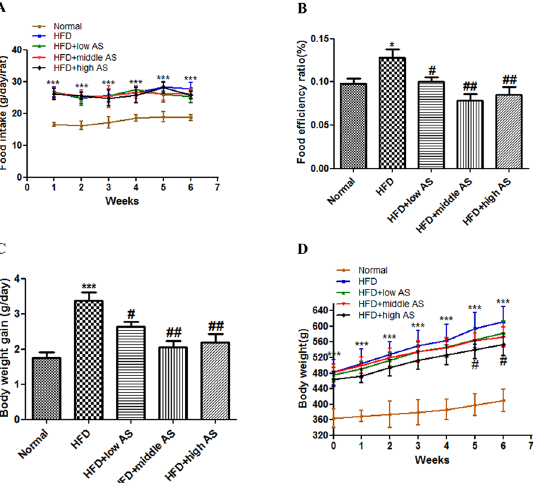
Fig 1. AS extract reduces HFD-induced obesity in rats. Rats were randomly divided into five groups: normal control, HFD model, and HFD with AS extract (100, 300, or 900 mg/kg). The extract was intragastric administered for 6 weeks. ( A ) Food intake per rat was recorded six times a week. ( B ) Food efficiency ratio was calculated as body weight gain divided by food intake. ( C ) Change in body weight was measured six times a week. ( D ) Body weight gain measured in a given week was subtracted from the weight in the previous week. Values are expressed as mean ± SE (n = 30). Significant differences were observed between normal and HFD groups. * P < 0.05, ** P < 0.01, *** P < 0.001 vs. normal group; # P < 0.05, ## P < 0.01, ### P < 0.001 vs. model